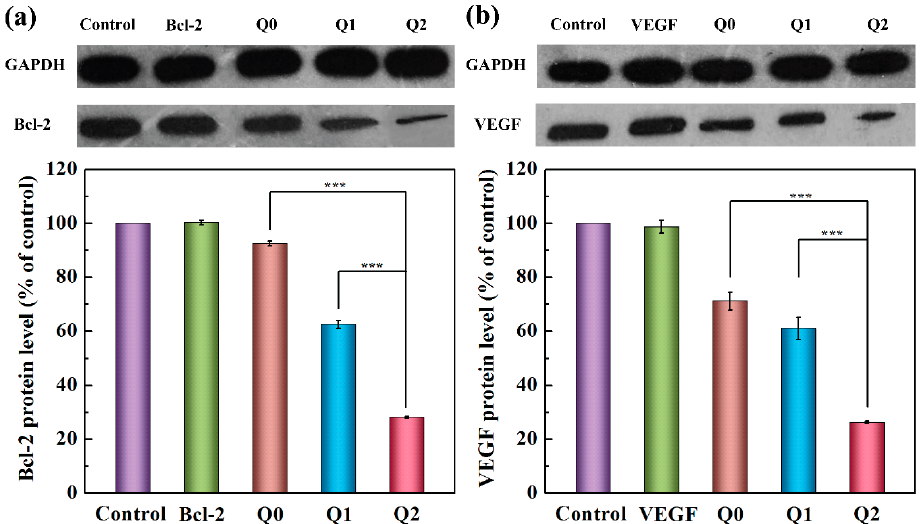
Figure 7. Relative Bcl-2 ( a ) and VEGF ( b ) protein expression levels in U87MG cells transfected with vector/siRNA polyplexes at an N/P ratio of 5:1. The GAPDH protein was used as a reference for the Western blot data. For (a,b), *** means that the p values of statistical analyses are < 0.001.